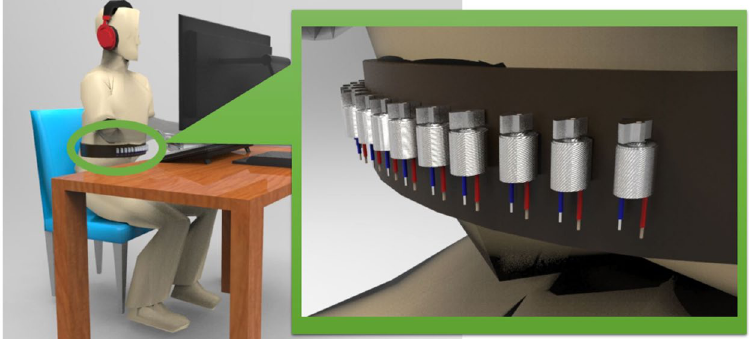
Figure 7. Experimental setup. Participants received tactile stimuli through a vibrotactile belt around their abdomen. The belt consists of 14 minatory vibration motors, which are fixed horizontally on the belt. Running a vibration motor in a specific location on the belt causes a tactile stimulus to a subject. They simultaneously received auditory stimuli through a headphone and visual stimuli through a